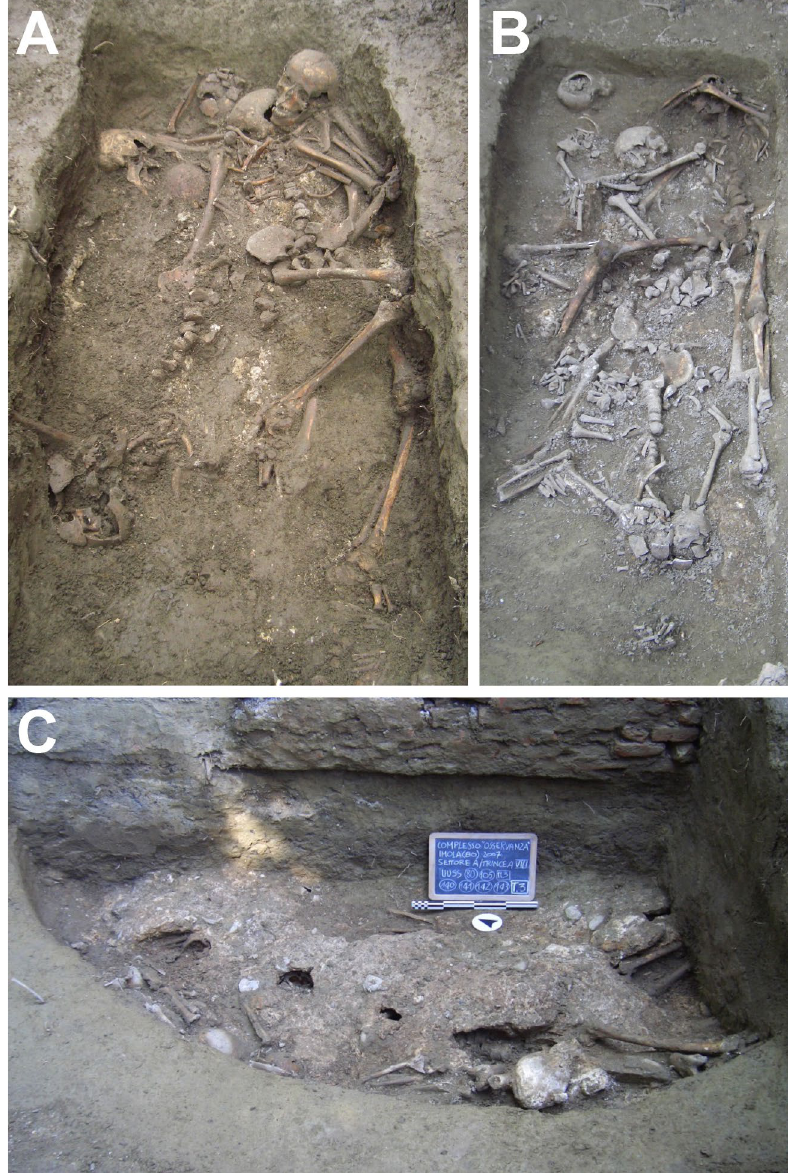
Figure 2. Pictures of grave 6 ( A ), grave 8 ( B ) and grave 3 ( C ) excavated in sector A of the Imola Osservanza complex (BO) in 2007. The use of lime, which was spread in multiple layers in between skeletons, is clearly visible in picture C (These pictures were previously published in Rinaldo et al. 7 , Photos by Xabier Gonzalez